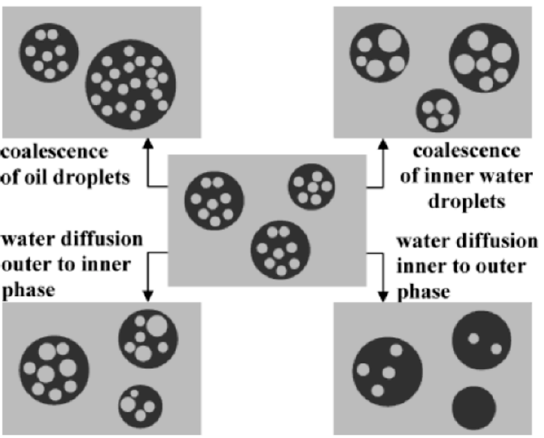
Figure 1. Schematic representation of destabilization routes of conventional double emulsions. Reprinted with permission from [9].